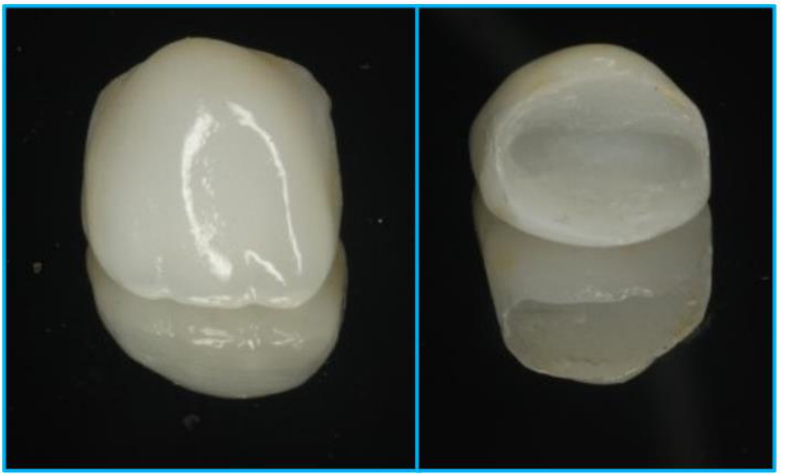
Figure 3. Anterior incisal onlay (AIO) Bilayer restoration—lithium disilicate veneered by feldspathic porcelain.